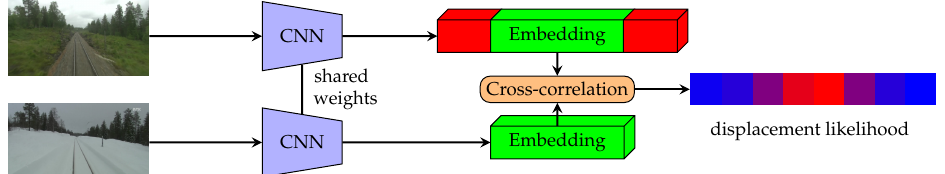
Figure 3. Diagram depicting the prediction pipeline for the methods presented. The inputs are two standard images, whose embeddings are then convolved together to get the final prediction of displacement. Note the additional roll padding in the representations.